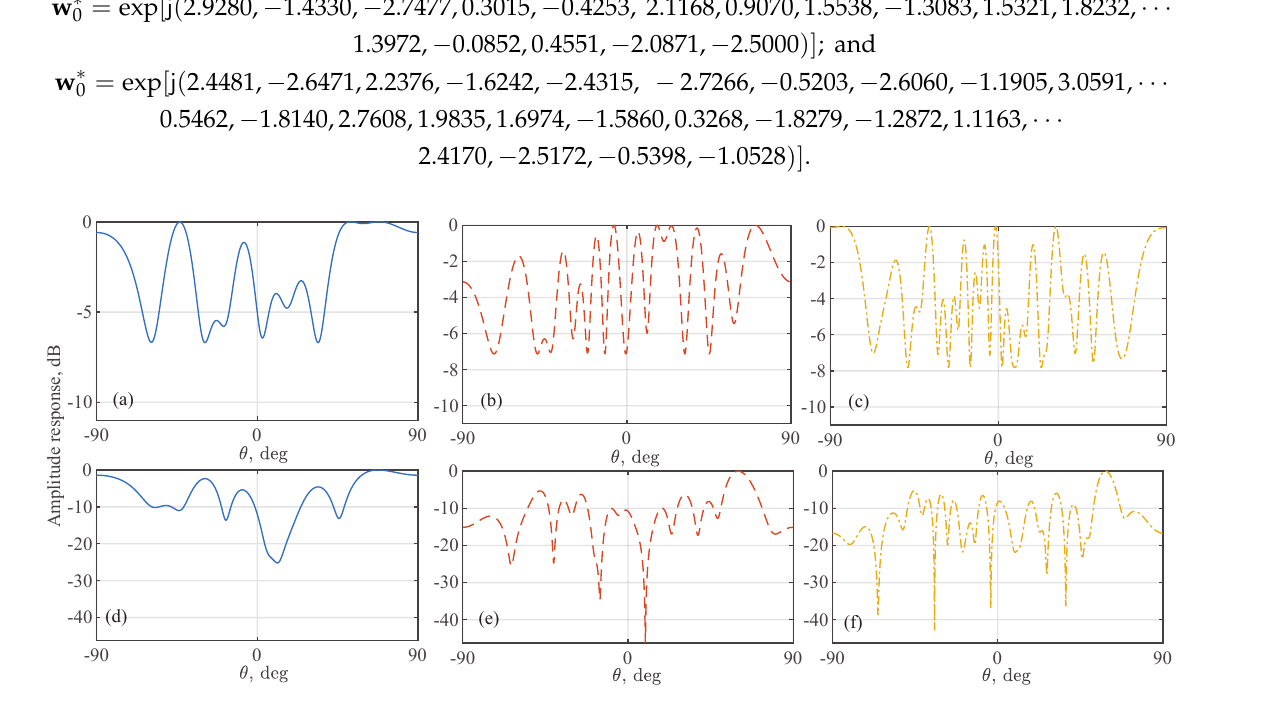
Figure 5. The amplitude response of the beams steered by the analog subarray, where subfigures ( a – c ) are obtained using w ∗ given in (25), and subfigures ( d – f ) correspond to w r with randomly generated 0 phases. The left, middle, and right columns are for N = 8, 16, and 24,